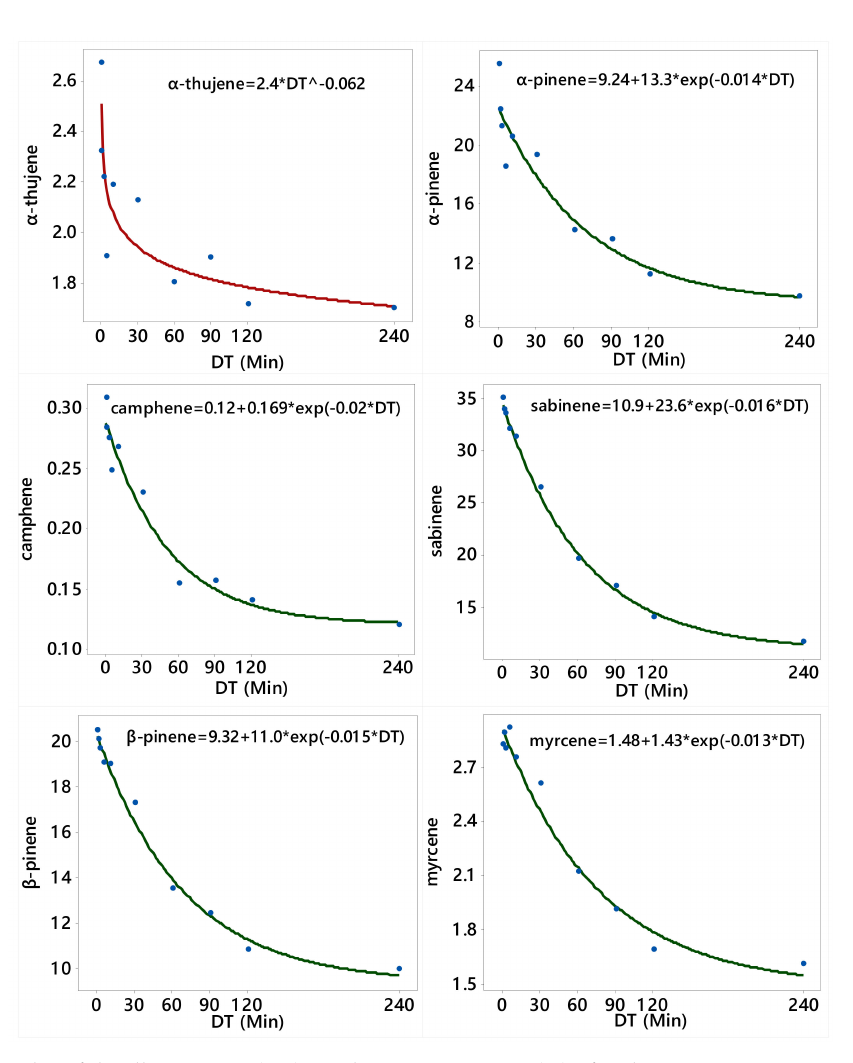
Figure 2. Plot of distillation time (DT) vs. the concentrations (%) of α -thujene, α -pinene, camphene, sabinene, β -pinene, and myrcene along with the fitted (solid line) power regression model ( α -thujene) and asymptotic (convex) regression model for the other five